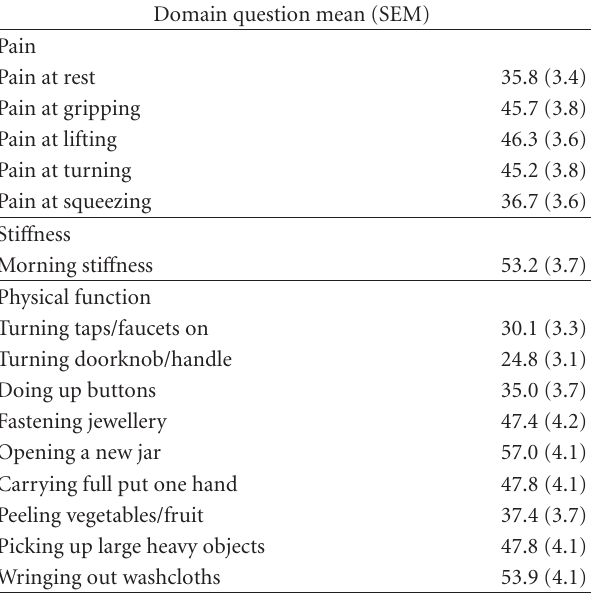
Table 1: Items and results of the AUSCAN. (Identical questions in both questionnaires are given in italics.)